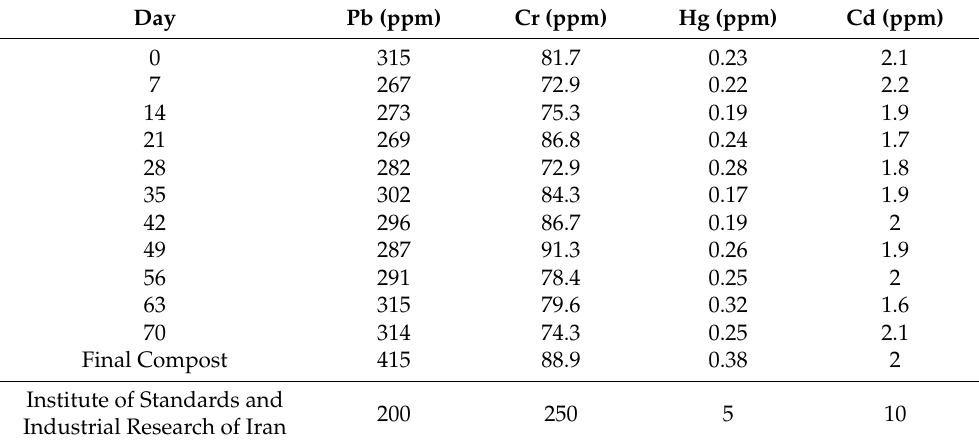
Table 1. Heavy metals concentration during